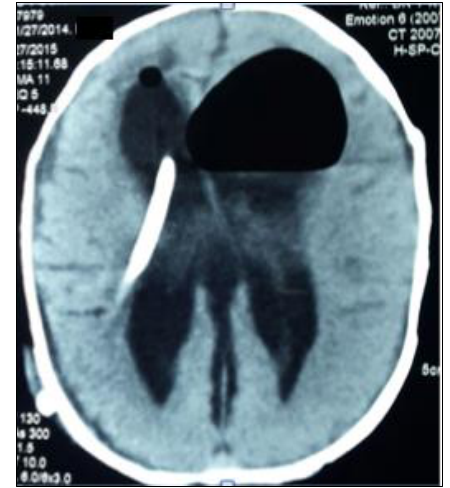
Figure 2: CT head showed air-fluid levels in both